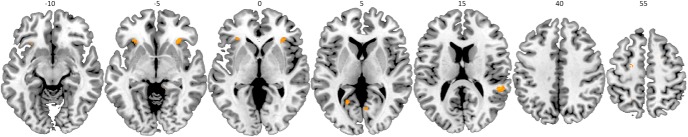
Main task effects across test sessions and level for proactive response inhibition (parametric regressors of Go). Images thresholded at p < 0.001 uncorrected (for illustration purposes), cluster-level (pFWE < 0.05) significant clusters are listed in Table 4i.